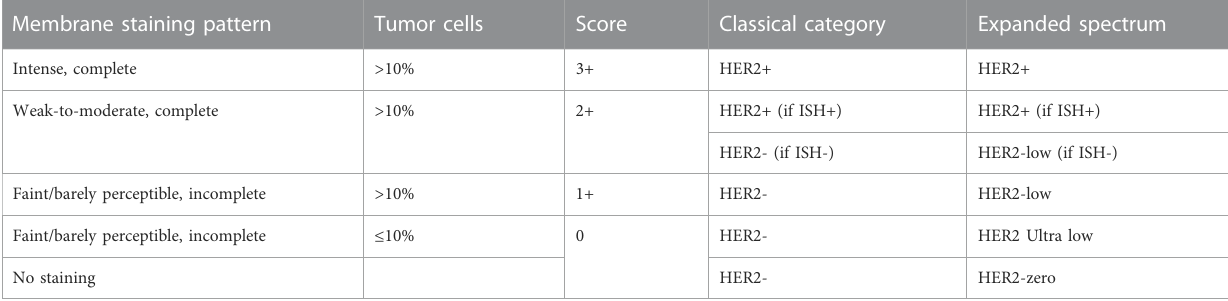
TABLE 1 HER2 scoring by immunohistochemistry according to the expanded spectrum of positivity (ASCO/CAP 2021). Membrane staining pattern Tumor cells Score Classical category Expanded spectrum